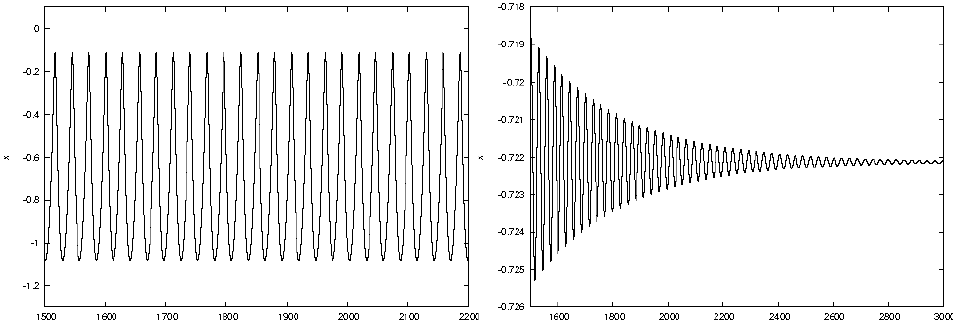
Figure 1. Time series of system (8), when (left) ε = 0.12 < ε c and (right) ε = 0.13 > ε c